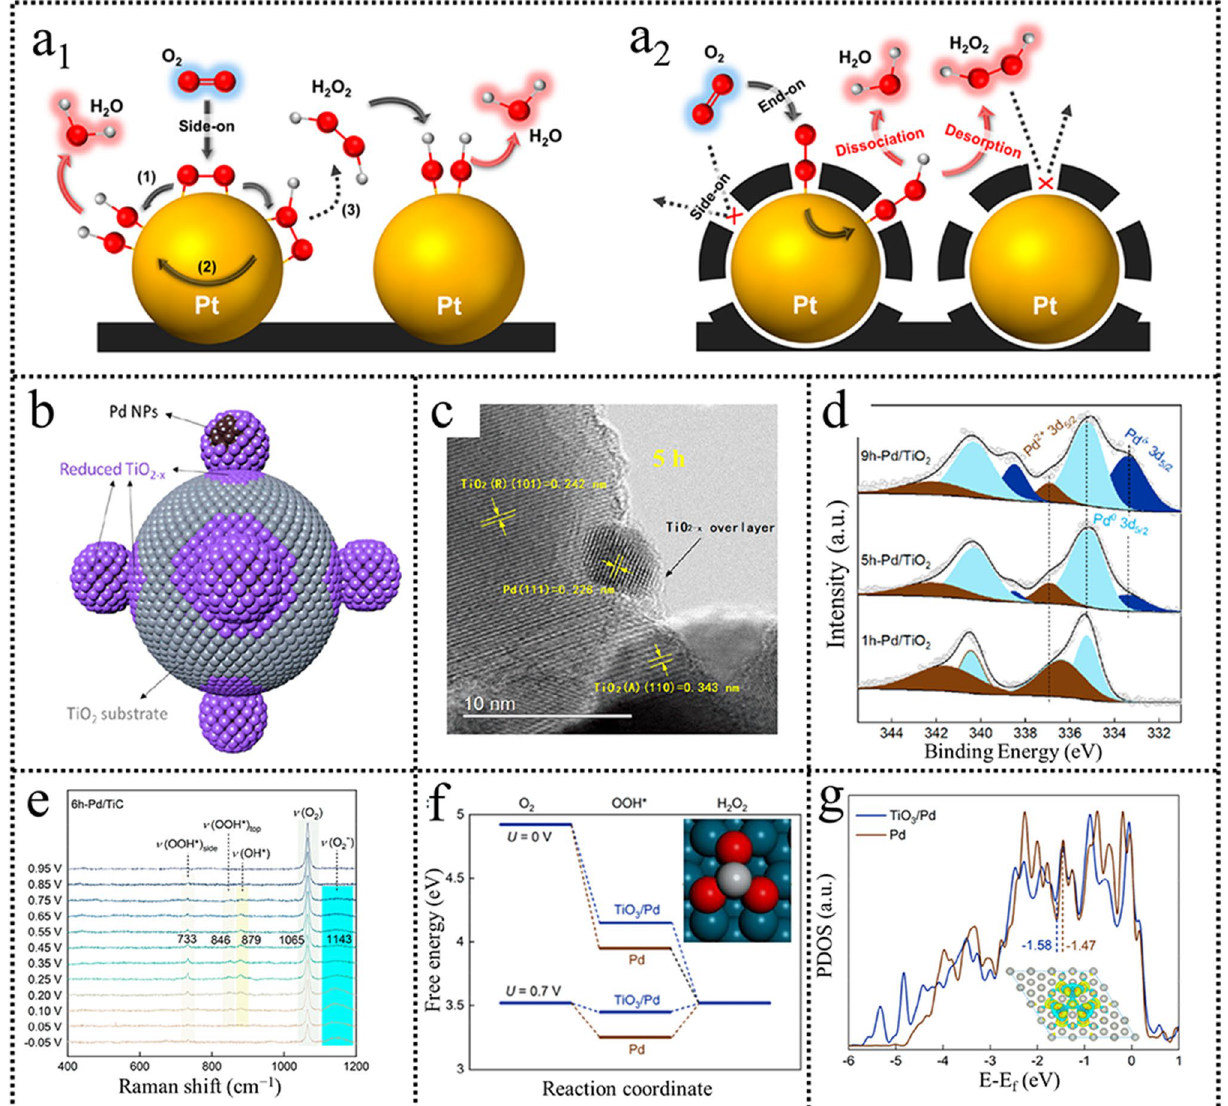
Fig. 6 a Molecular O 2 adsorption configuration on Pt/C and C(Pt)/C. Reproduced with permission [62]. Copyright 2014, American Chemical Society. b Schematic illustration showing the encapsulation of TiO 2− x overlayer on Pd NPs. c HR-TEM image 5 h–Pd/TiO 2 . d XPS spectra of ball-milled Pd/TiO 2- x samples. e In situ Raman spectra recorded over 6 h-Pd/TiC. f Free energy diagrams for the two-electron-transfer ORR over TiO 3 /Pd and Pd(111). g Projected density of states over TiO 3 /Pd and Pd(111). Reproduced with permission [63]. Copyright 2022, American Chemical Society. (Color figure